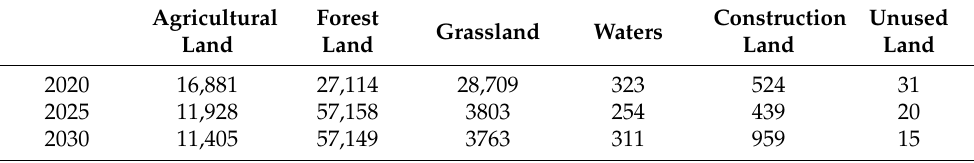
Table 5. Land-use type